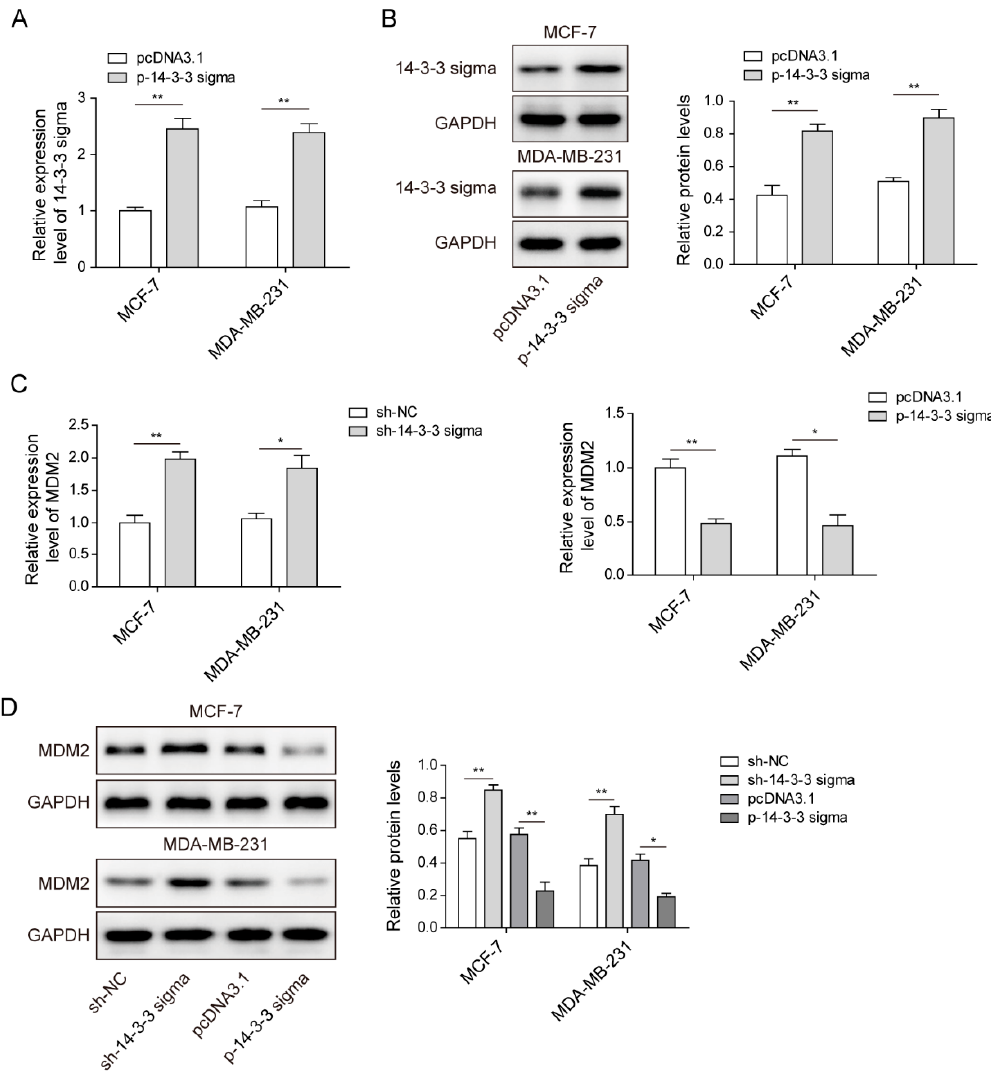
Figure 4. 14-3-3 sigma could negatively regulate the expression of MDM2 in breast cancer cells. ( A ) Relative gene expression of 14-3-3 sigma in MCF-7 and MDA-MB-231 cells transfected with either pcDNA3.1 or p-14-3-3 sigma measured by qPCR. ( B ) Relative protein level of 14-3-3 sigma in MCF-7 and MDA-MB-231 cells transfected with either pcDNA3.1 or p-14-3-3 sigma measured by Western blotting. ( C ) Relative gene expression of MDM2 in MCF-7 and MDA-MB-231 cells transfected with either pcDNA3.1 or p-14-3-3 sigma measured by qPCR. ( D ) Relative protein level of MDM2 in MCF-7 and MDA-MB-231 cells transfected with either pcDNA3.1 or p-14-3-3 sigma measured by Western blotting. * p < 0.05, ** p < 0.01.